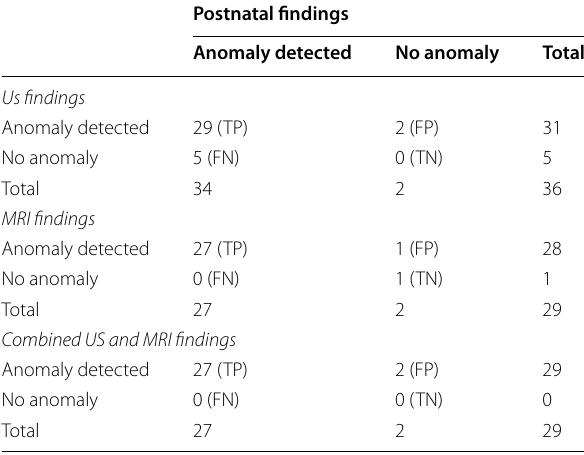
Table 3 Accuracy of antenatal US and MRI in the detection of congenital GIT anomalies with reference to postnatal findings among our studied